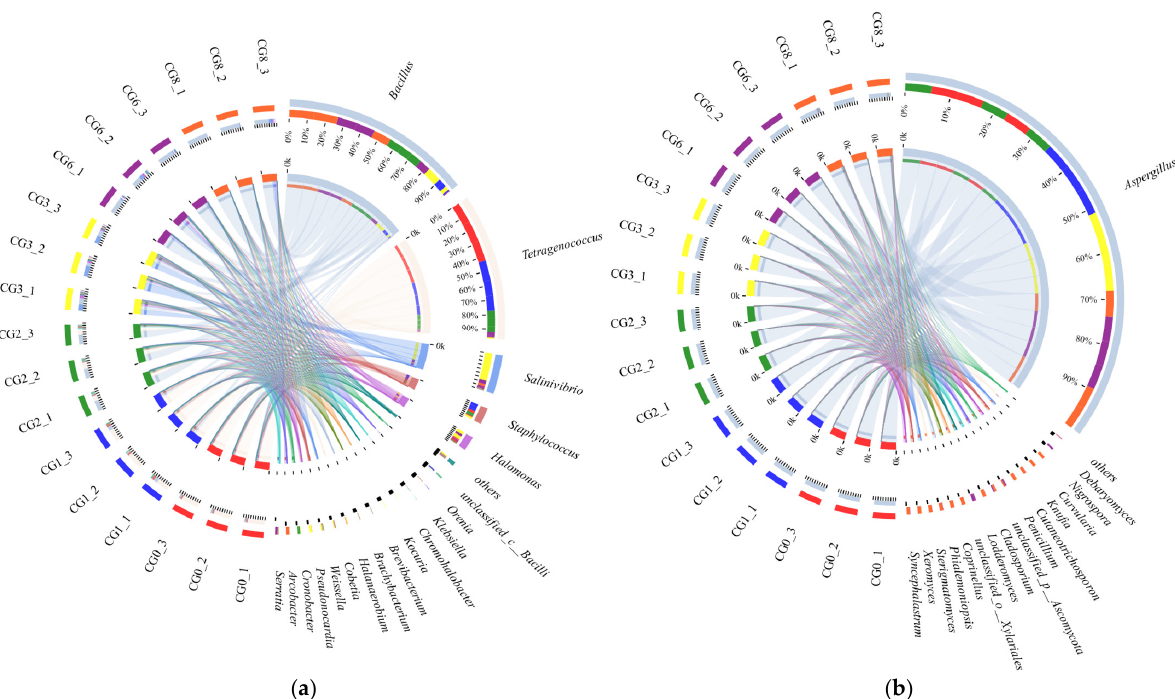
Figure 3. Circos of bacteria ( a ) and fungi ( b ) of Caishiji soybean paste in different fermentation stages. The right half circle represents the distribution of the species in different samples at the taxonomic level, the outer ribbon represents the species, the inner ribbon color represents the different groups, and the length represents the distribution of the sample in a species.